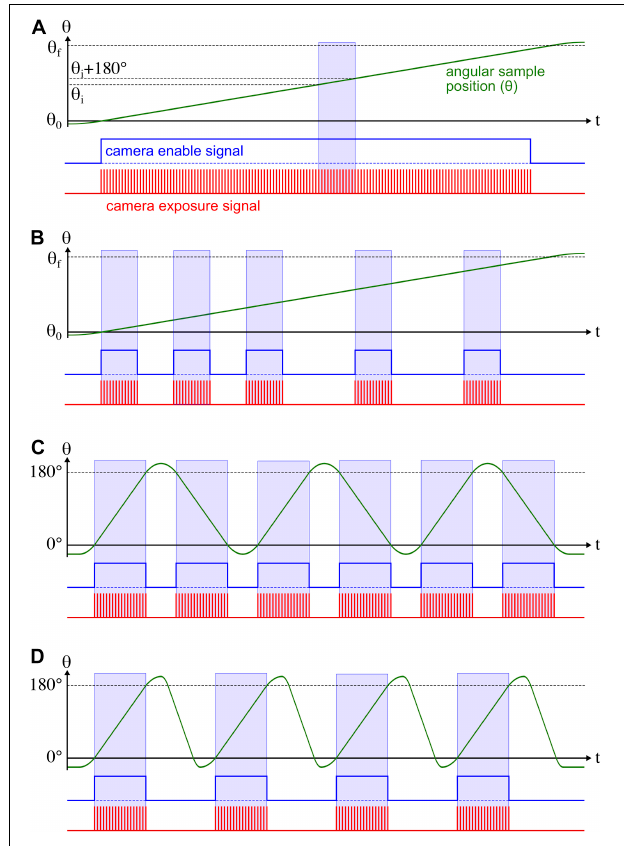
FIGURE 2 | Illustration of different data acquisition modes for fast tomographic measurements. The angular position of the sample is displayed by the green line as a function of time in the θ (t) coordinate system. Below this plot, typical TTL control signal sequences are represented by the blue line for the camera enable signal and the red line for individual camera frame exposure signals. The translucent blue rectangles mark the boundaries for individual tomographic scans. Four different acquisition modes are shown: (A) continuous acquisition during a continuous rotation of the sample. The total rotation angle covers many times the 180 ◦ range required to reconstruct a single volume. (B) The so-called “sequence scan,” where acquisition windows can be programed to occur at configurable positions of the continuous rotation, allowing for a tighter control of the time series properties and scanning intervals. (C,D) Where a continuous rotation of the sample is not possible, scans can be acquired in a back-and-forth motion of the sample, either in both movement directions (C) or only along one direction with a rewinding operation in between (D)